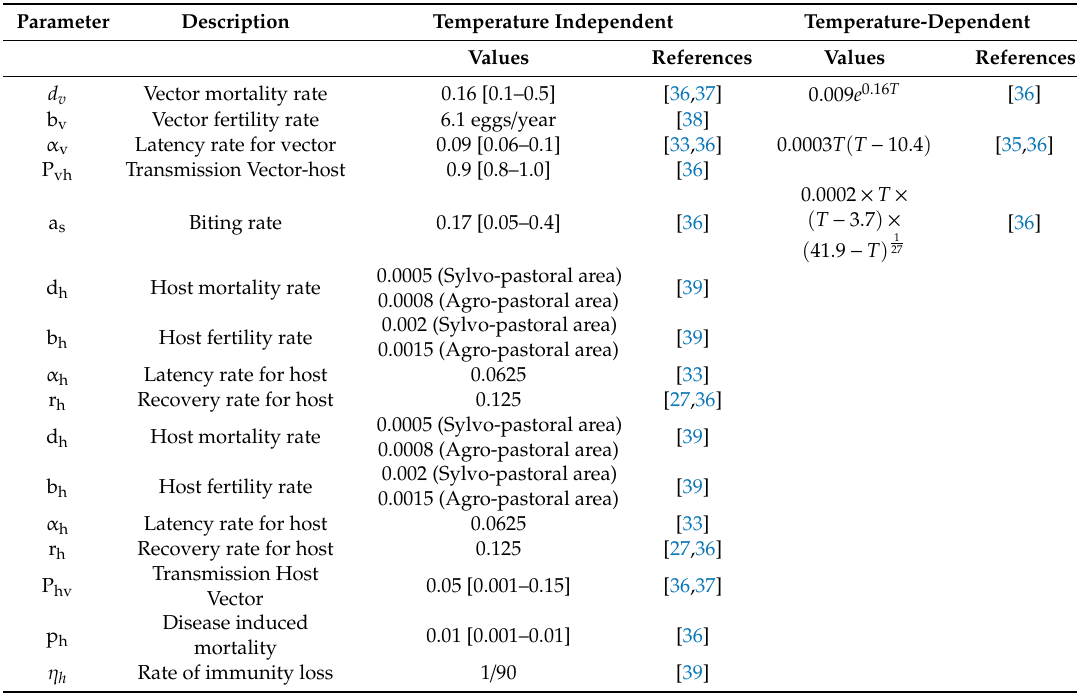
Table 1. Bluetongue epidemiological